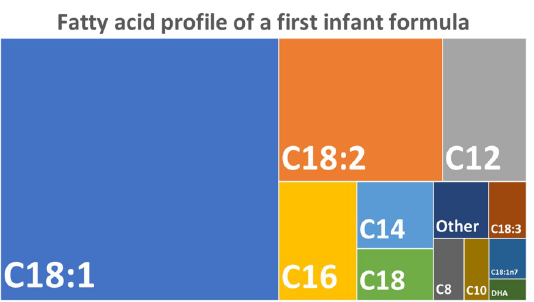
Fig 2. The total FA composition of the investigated first infant formula as determined using gas chromatography- mass spectrometry, based on data from the analysis of unheated samples (control A).